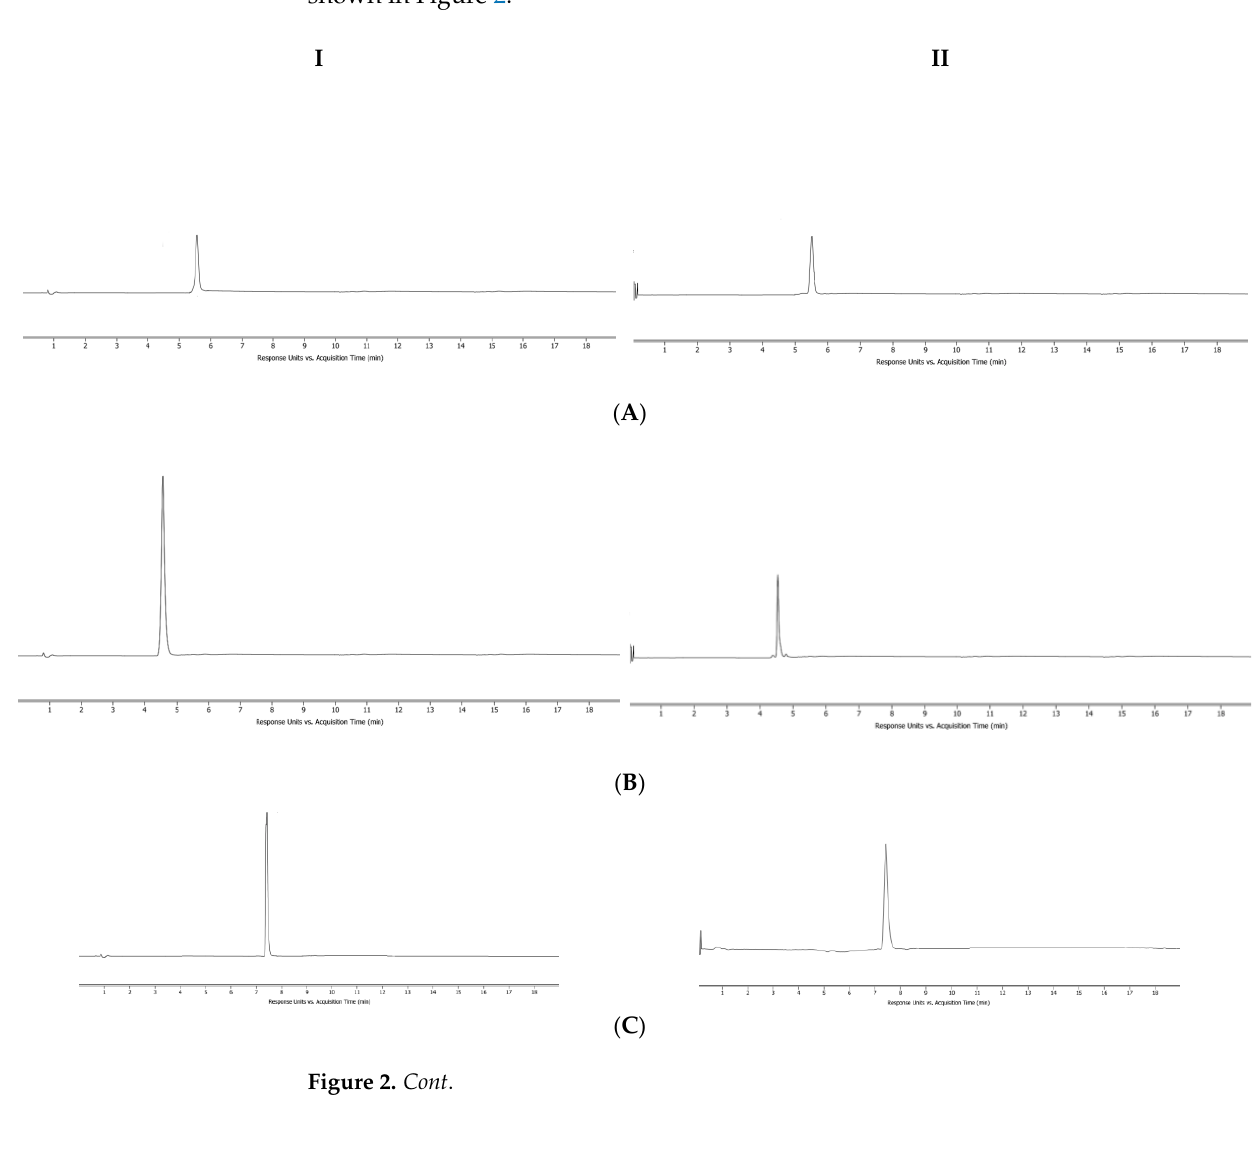
Figure 1. Chemical structures and mass spectra of ( A ) brucine, ( B ) strychnine, ( C ) liquiritin, ( D